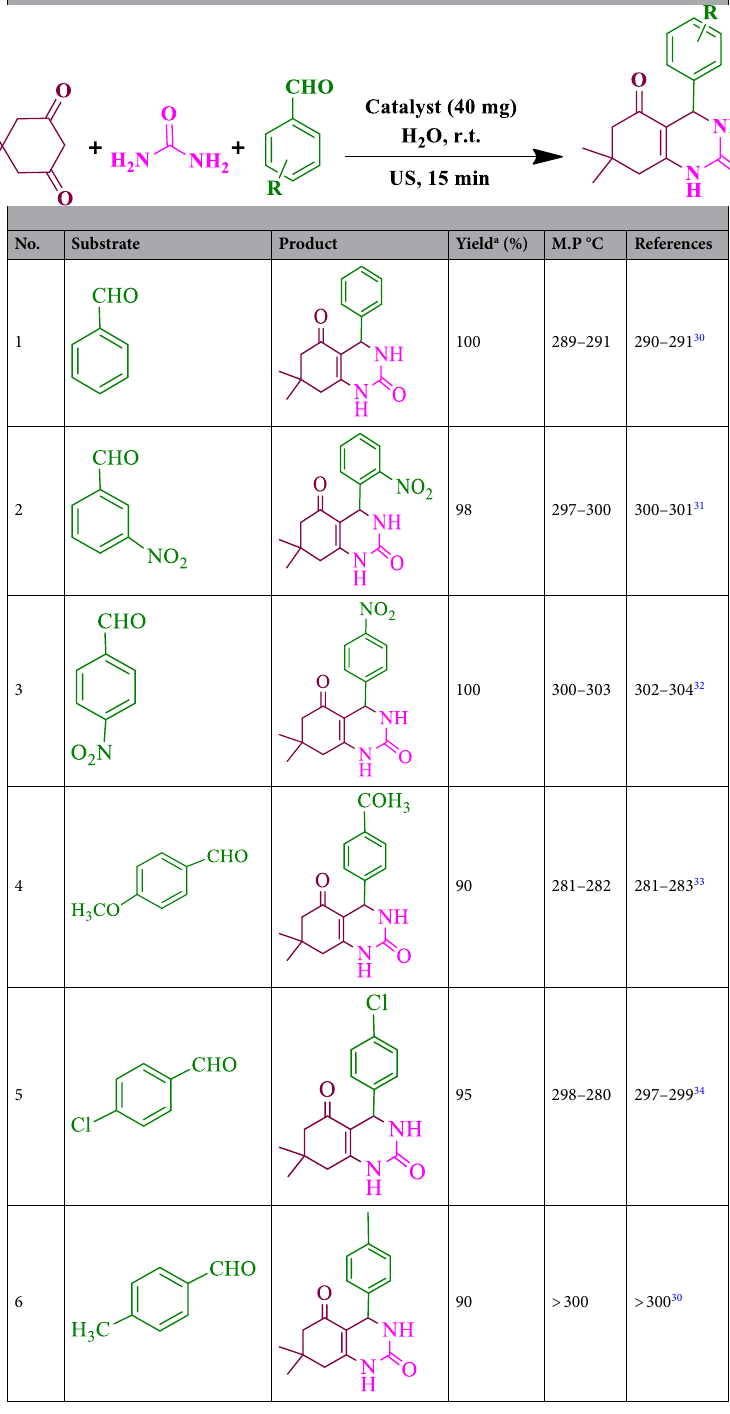
Table 1. Synthesis of octahydroquinazolinone derivatives catalyzed by Bent-Gu-CD under ultrasonic irradiation condition. Reaction condition: Substrate (1 mmol), urea (1 mmol), dimedone (1 mmol), H 2 O (15 mL) at 25 °C in 15 min under ultrasonic irradiation. a Isolated